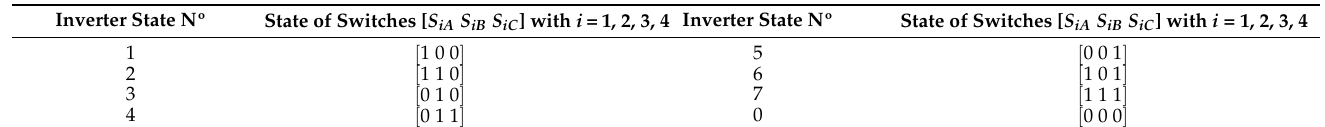
Table 1. Switching states of the individual three-phase inverters.